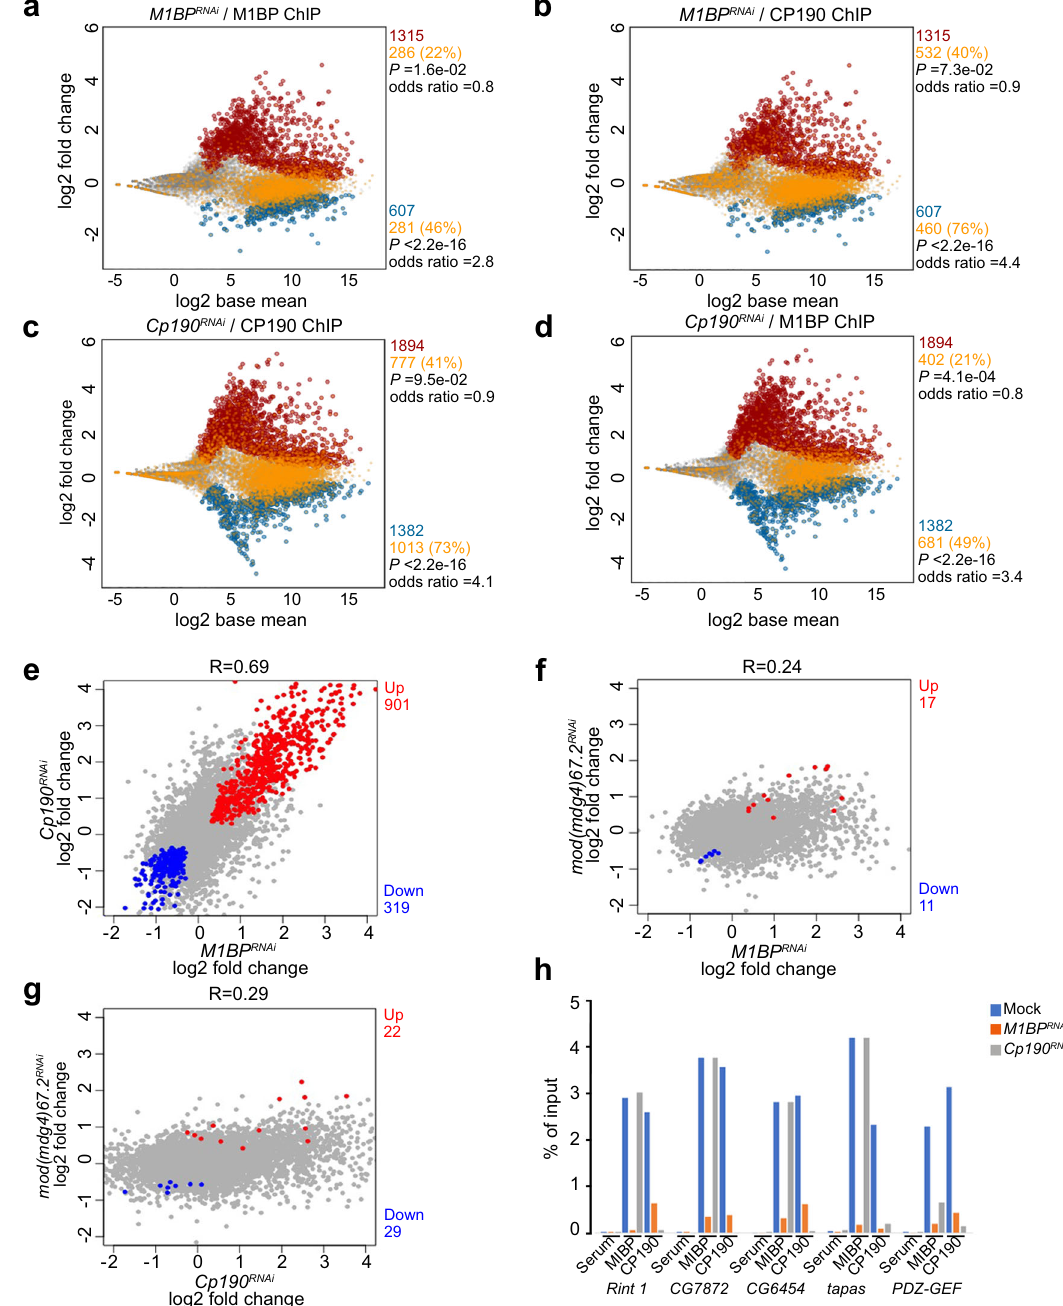
Fig. 4 M1BP and CP190 transcriptionally regulate a common set of genes. a , b MA plots showing changes in neuRNA levels upon depletion of M1BP. Statistically signi fi cant changes include 1315 upregulated genes (red) and 607 downregulated genes (blue) using P adj < 0.05. Unchanged genes are indicated in gray. Gene promoters containing M1BP peaks ( a ) or CP190 peaks ( b ) are additionally colored yellow. Two-sided Fisher ’ s exact test was used. c , d MA plots showing neuRNA-seq affected genes after depletion of CP190. Signi fi cantly upregulated genes (1894, red) and downregulated genes (1382, blue) are shown. Genes containing CP190 ( c ) or M1BP ( d ) at their promoters are shown in yellow. Fisher ’ s exact test (two-sided) was used. e – g Scatter plots comparing neuRNA-seq pro fi les of M1BP and Cp190 knockdowns ( e ), M1BP and mod(mdg4) knockdowns ( f ), or Cp190 and mod(mdg4) knockdowns ( g ). Pearson ’ s R corresponds to correlation coef fi cient between two pro fi les. Common upregulated genes are indicated in red, and common downregulated genes are indicated in blue. h Differentially decreased CP190 peaks in M1BP RNAi associated with the promoter of downregulated genes affected in both M1BP and Cp190 knockdowns are veri fi ed by ChIP-qPCR. Percent input DNA precipitated is shown for each primer set. Average values from n = 2 biological replicates measured using four technical replicates are shown. Detailed description of each site is summarized in Supplementary Table 5, and C t values are listed in Source Data